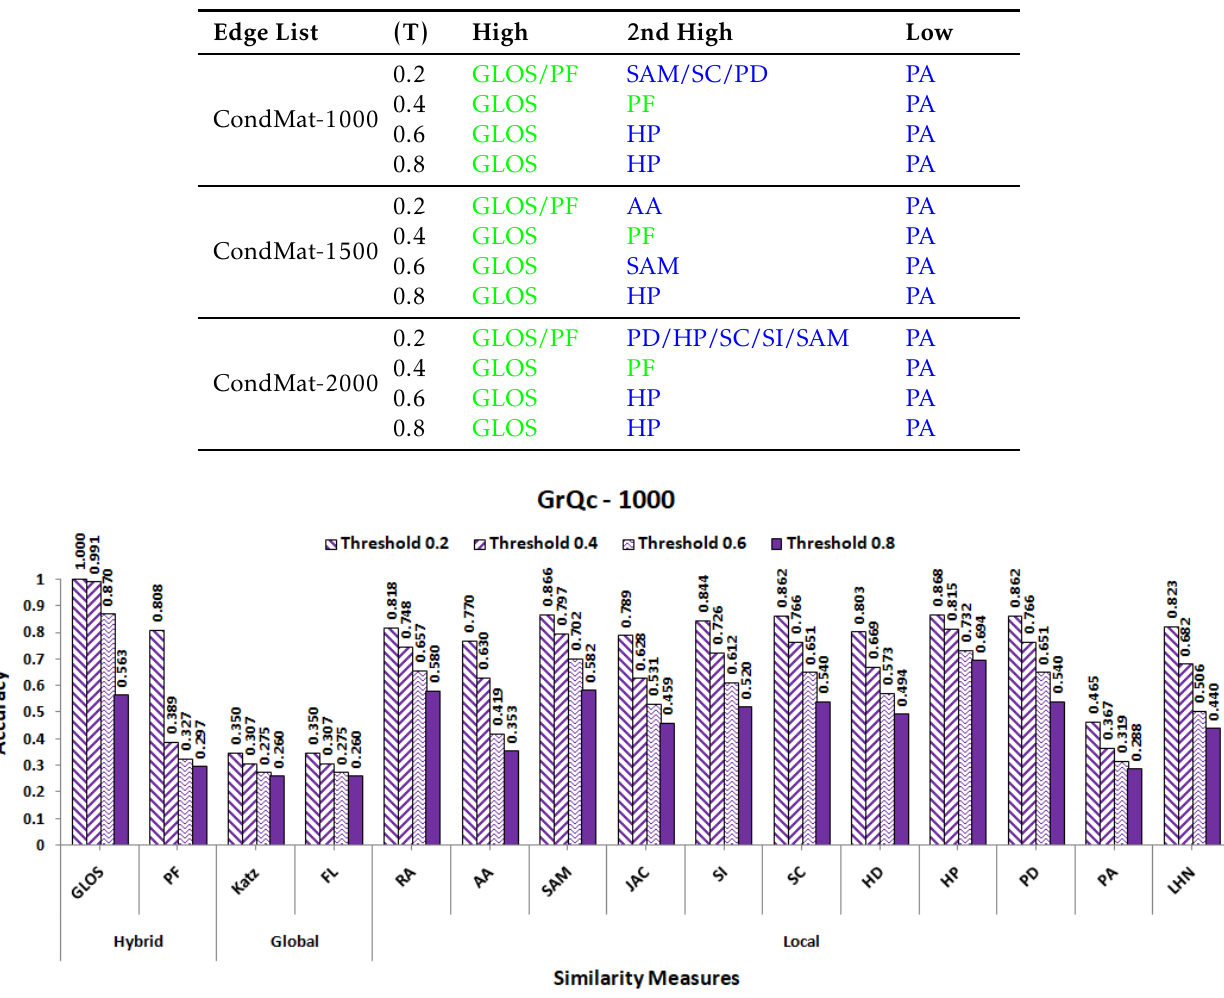
Table 4. The table presents the results of accuracy on CondMat Dataset. Where, (T) represents the threshold, High represents the similarity measures obtaining highest accuracy, 2nd High corresponds to the similarity measures obtained second highest accuracy and low represents the similarity measures obtained lowest accuracy. The red color shows the Global approaches, the blue color shows the Local approaches and the green color shows the Hybrid approaches.